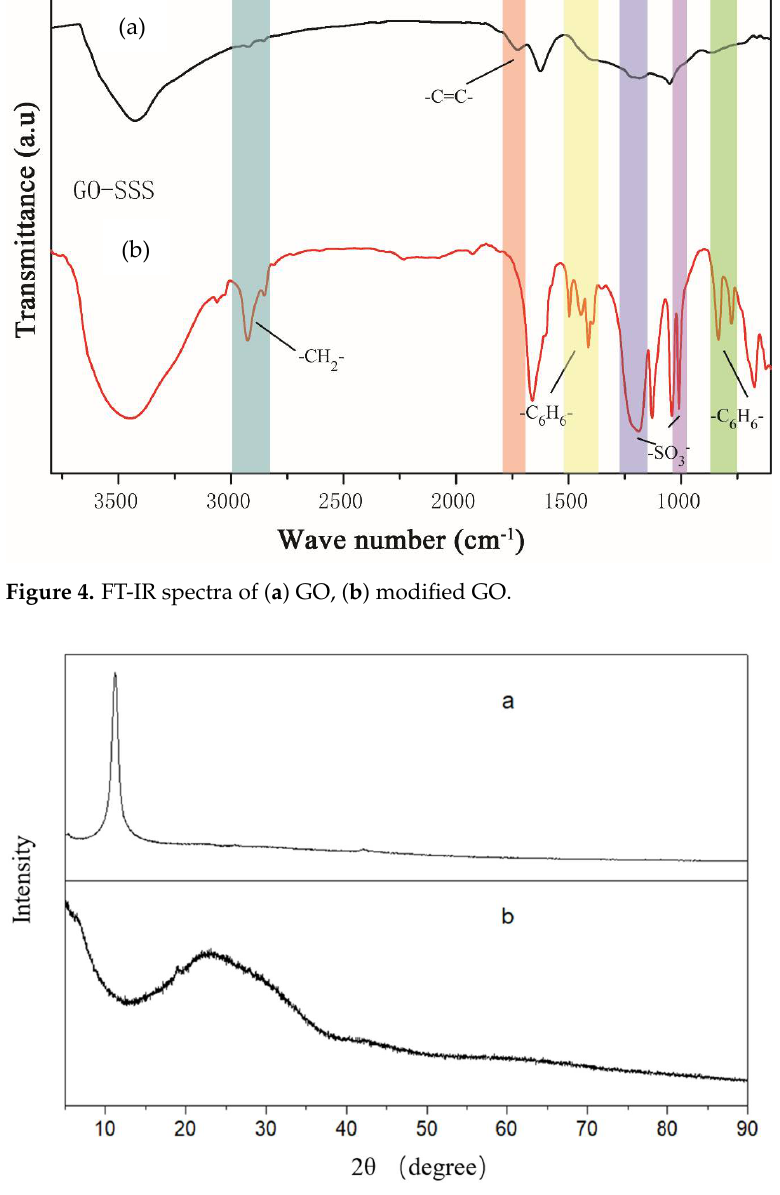
Figure 5. XRD pattern of ( a ) GO, ( b ) GO-SSS.